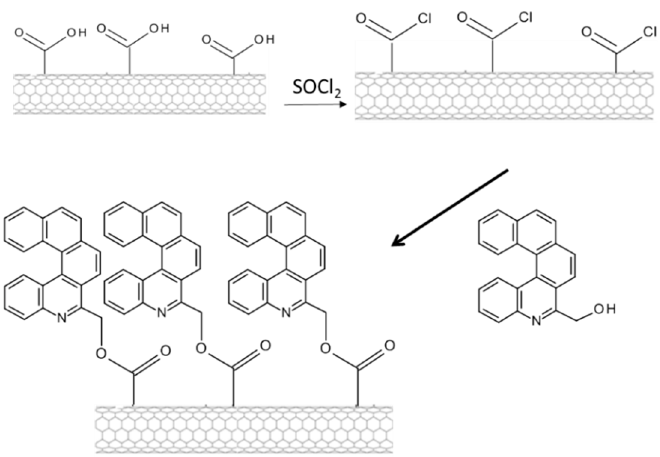
Figure 4. Functionalization of carbon nanotubes by 6-hydroxymethyl-5-aza[5]helicene. A similar approach, on the same aza[5]helicene, used 5-bromo-1-pentene as the radical precursor and the TTMSS/AIBN system to generate silicon radicals for the abstraction of bromine atom [43] to produce a pentenyl radical. In this way, the 5-pentenyl-substituted azahelicene 23 is obtained, and the double bond can be reacted to introduce different types of further functional groups. In particular, in [44], it was reacted with thioacetic acid CH 3 CS-OH, to obtain S-[5-(6-(5-aza[5]helicenyl)pentyl] ethanethioate 24 (Scheme 22).